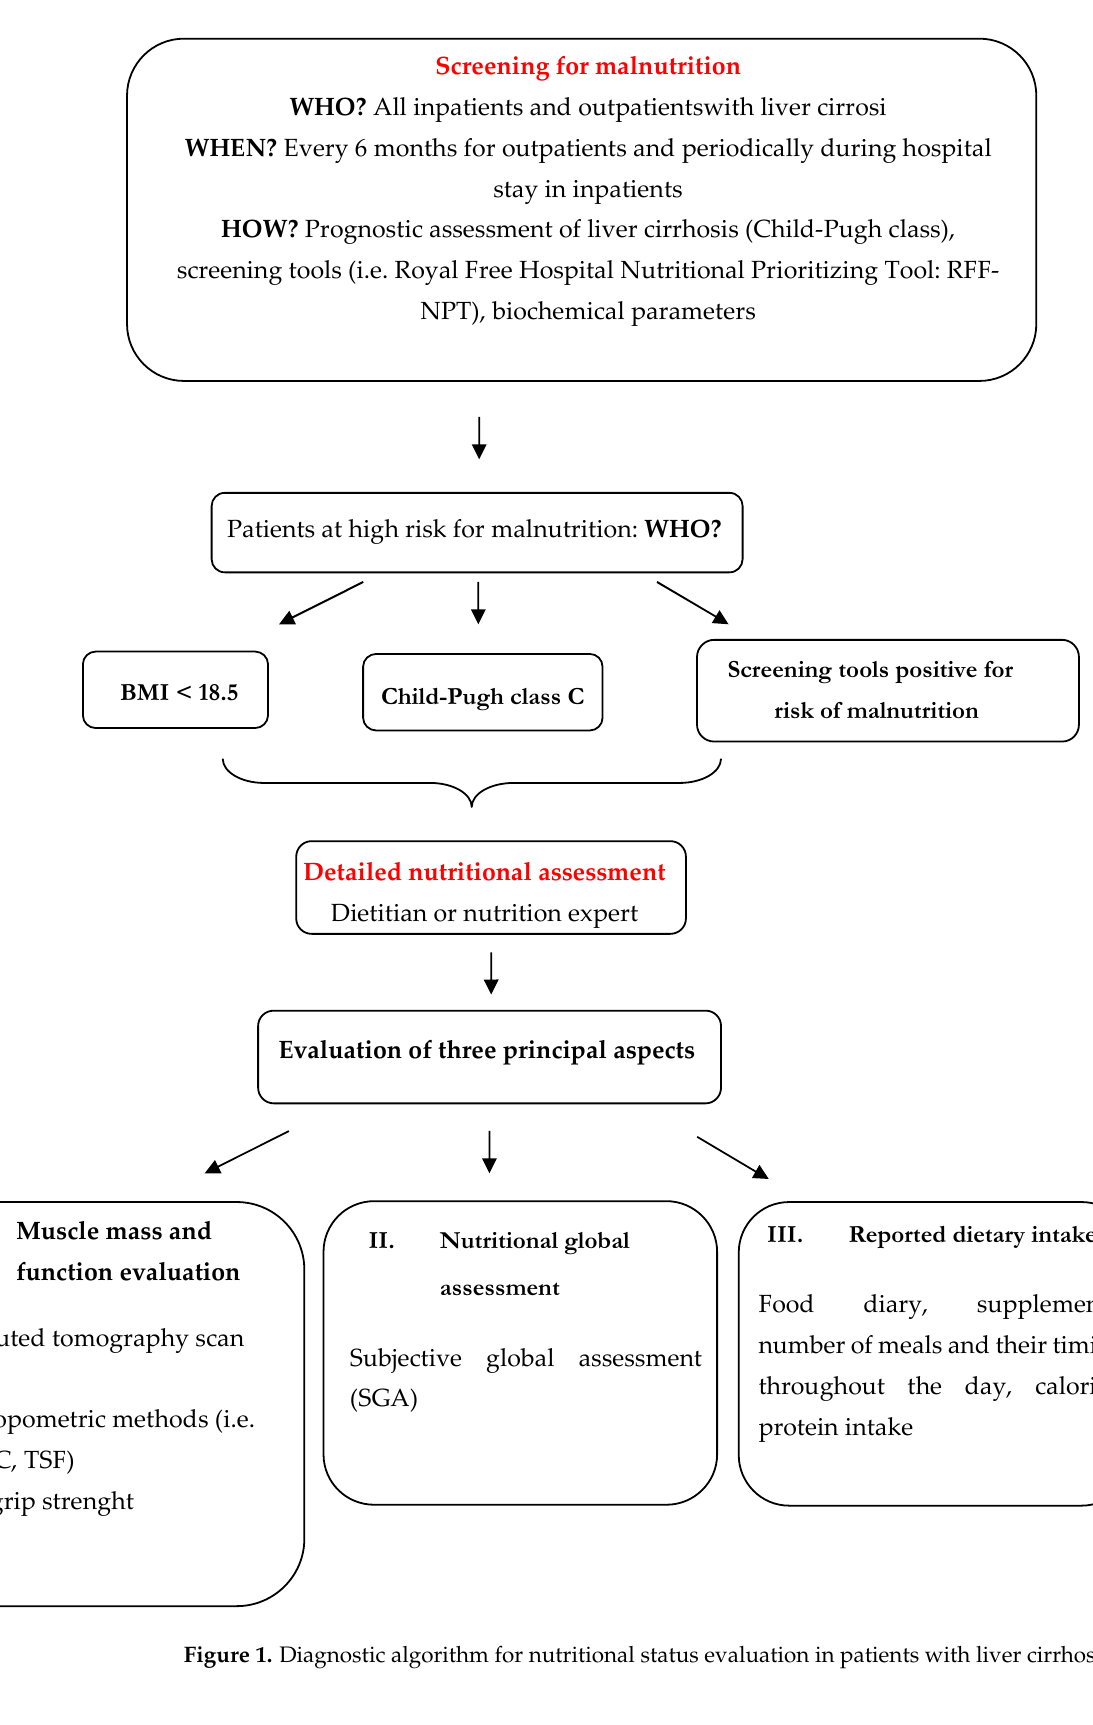
Figure 1 . Diagnostic algorithm for nutritional status evaluation in patients with liver cirrhosis. Figure 1. Diagnostic algorithm for nutritional status evaluation in patients with liver